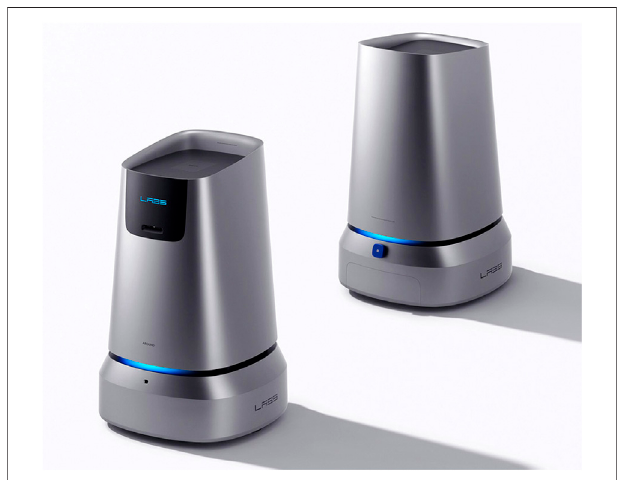
FIGURE 1B | The robotic platform developed by our